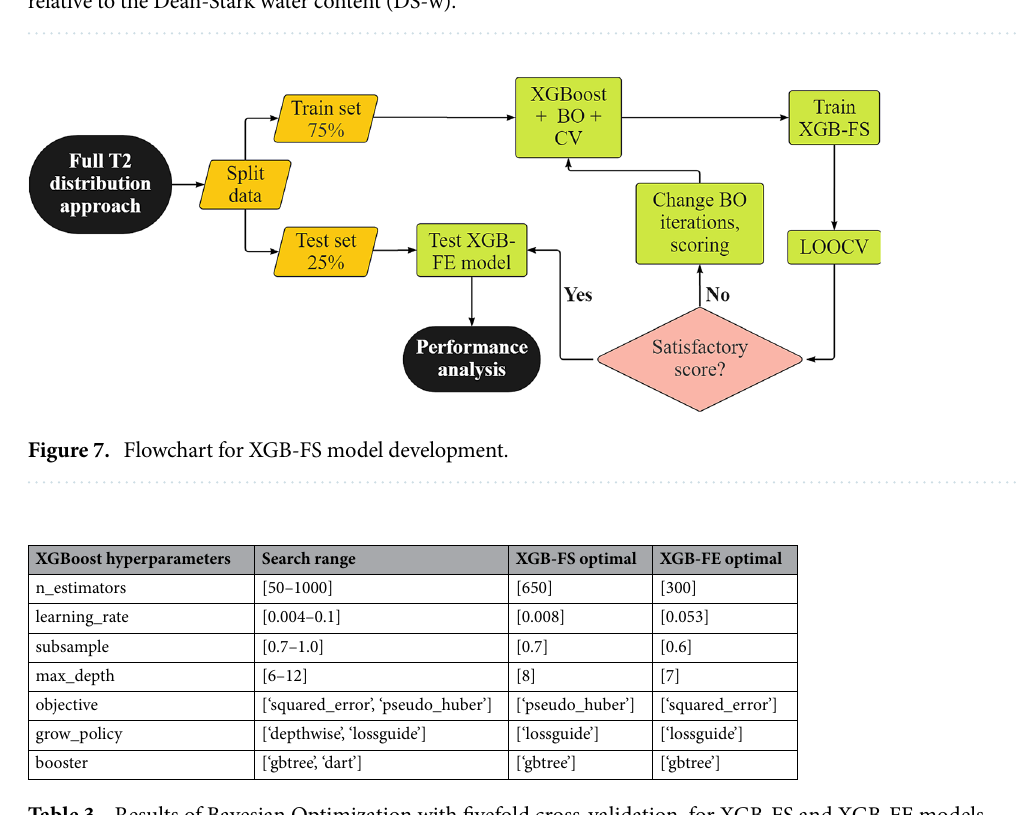
Figure 6. Mutual information regression scores for five NMR parameters and bulk density (input features) relative to the Dean-Stark water content (DS-w).